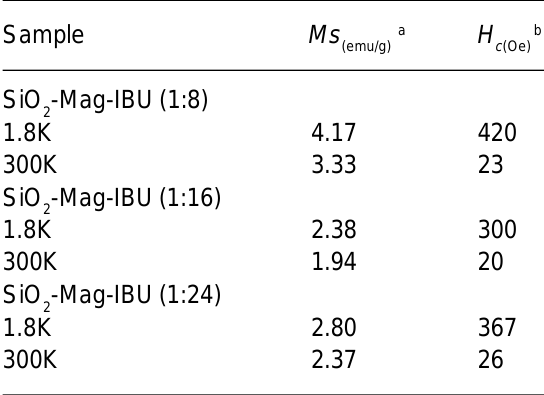
Table 5. Magnetic values obtained at 1.8 and 300K of SiO -Mag-IBU 2